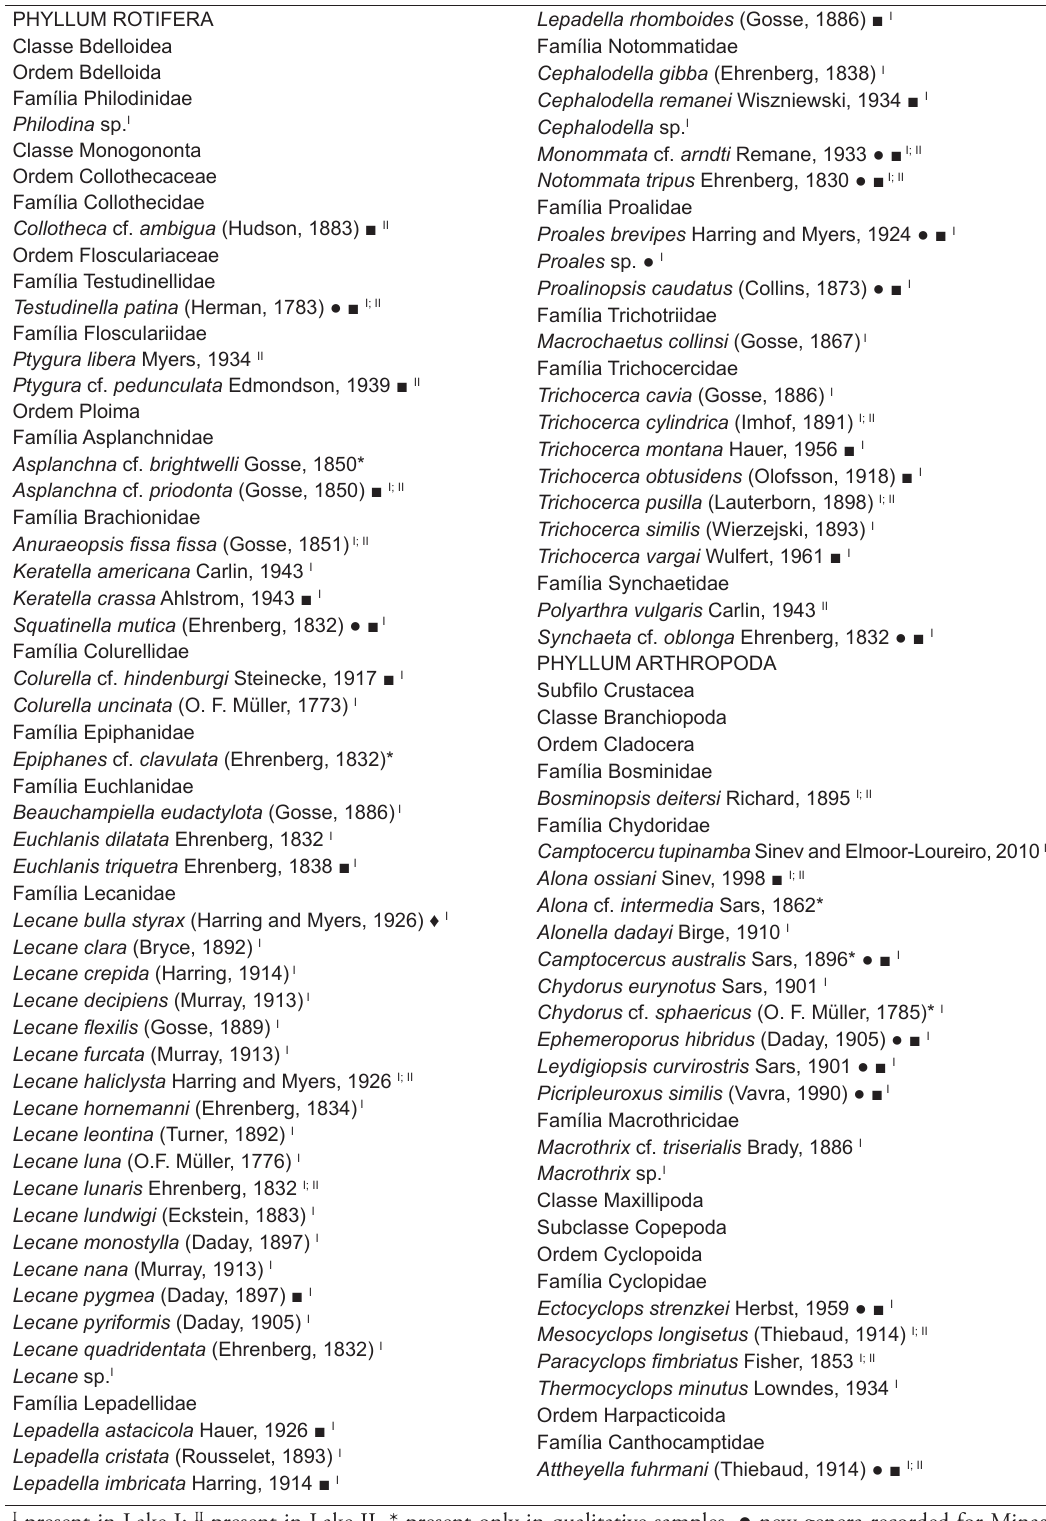
Table 1. Species list of zooplankton from Clube Caça e Pesca Itororó de Uberlândia, Minas Gerais